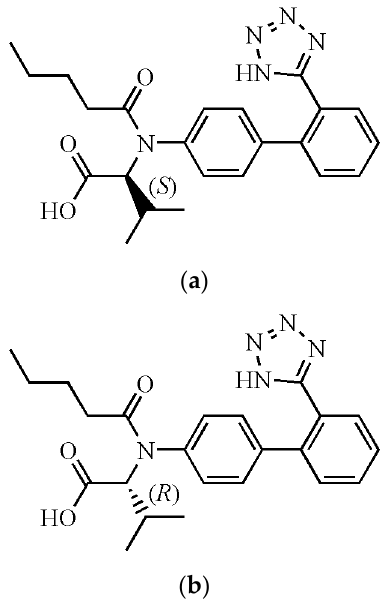
Figure 1. Chemical structure of valsartan: ( a ) S -configure; ( b ) R -configure.